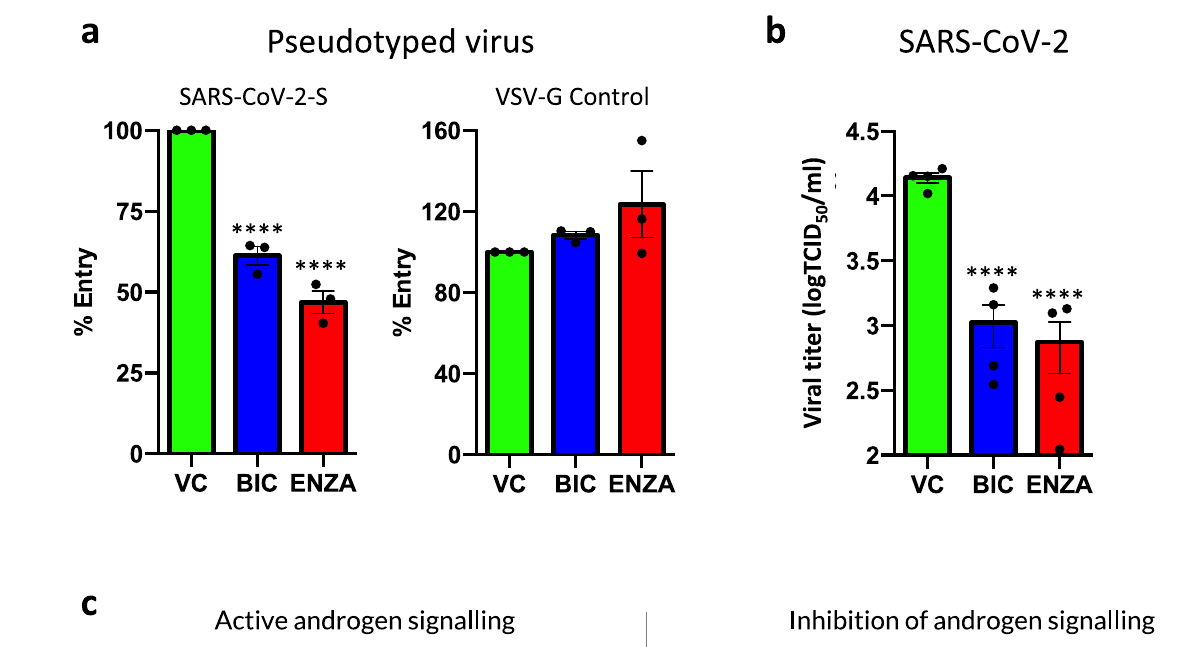
Fig. 6 Potential regulatory regions in the TMPRSS2 promoter. a ChIP-sequencing peaks of AR, FOXA1, GR and H3K27ac in LNCaP cells; FOXA1, GR and H3K27ac in A549 lung cells; AR, H3K27ac, FOXA1, GR, ESR1 in MCF-7 breast cancer cells. The TMPRSS2 gene is highlighted in the purple shaded box and the potential regulatory region 1 is boxed in yellow, the potential regulatory region 2 is boxed in orange. Potential AREs are marked in blue boxes (MA0007.2) or green (determined by 24 ). Position of potential MA0007.2 motifs around the TMPRSS2 gene separated into two regions, the fi rst region (regulatory region 1) covering areas of TSS and promoter/enhancers, the second region (regulatory region 2) covers more distant enhancer regions. b AR motif MA0007.2 from JASPAR curated motif database. c ChIP-qPCR of AR binding, and IgG control, to AR-motif-containing sites within regulatory regions 1 and 2 in LNCaP, A549, and H1944 cells treated with 10 nM dihydrotestosterone (DHT) or vehicle control (VC) for 4 h. Data are normalised to input and made relative to AR-IP VC. Data are the mean of three independent repeats. A maximum of one outlier was removed from each treatment using Grubbs ’ test (alpha = 0.05). Source data are provided as a Source Data